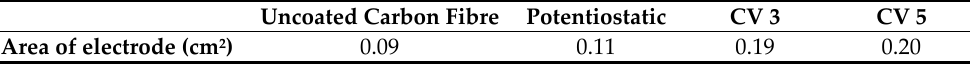
Table 1. Surface area of uncoated carbon fibre and rGO coated carbon